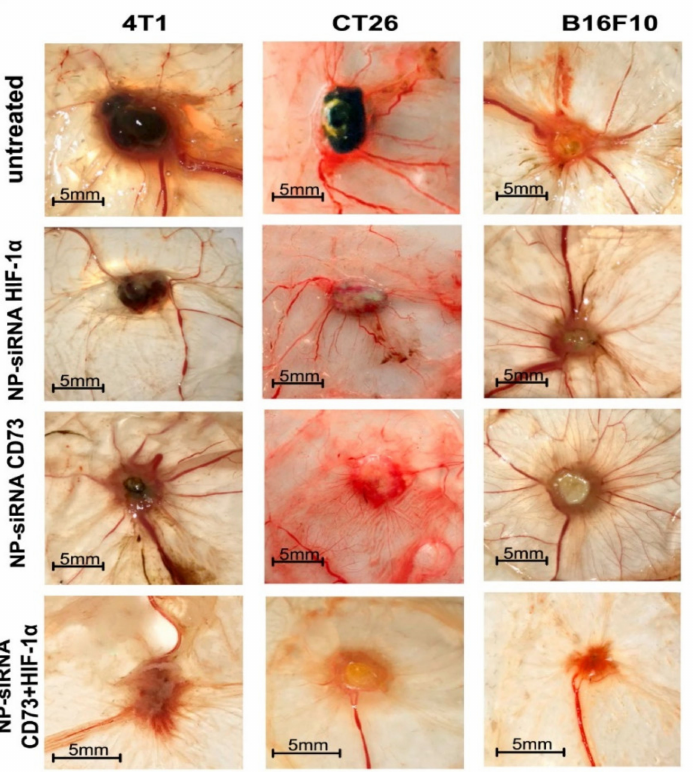
Figure 33. CAM assay of HIF-1 α /CD73 siRNA loaded TAT-TMC/TC/SPION nanocarriers sup- pressed in vivo tumor development and angiogenesis [221]. Reproduced with permission from Elsevier